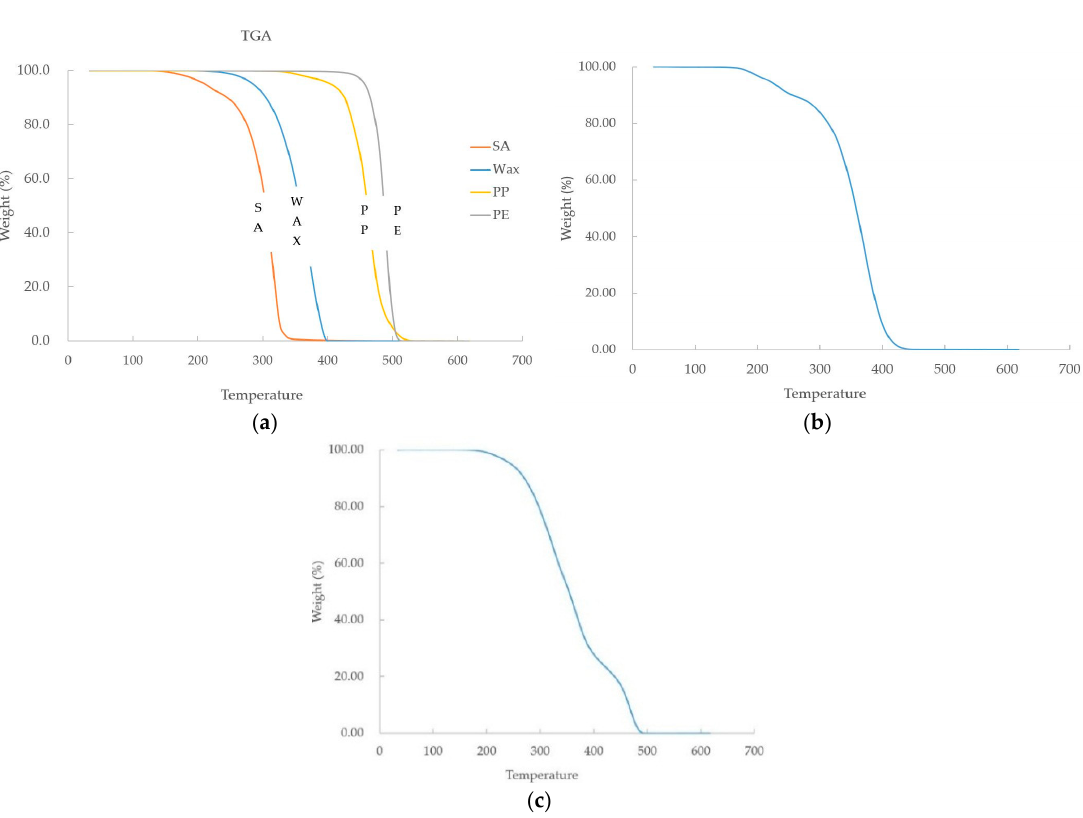
Figure 10. TGA results of ( a ) pure binder; ( b ) space holder; and ( c ) feedstock.